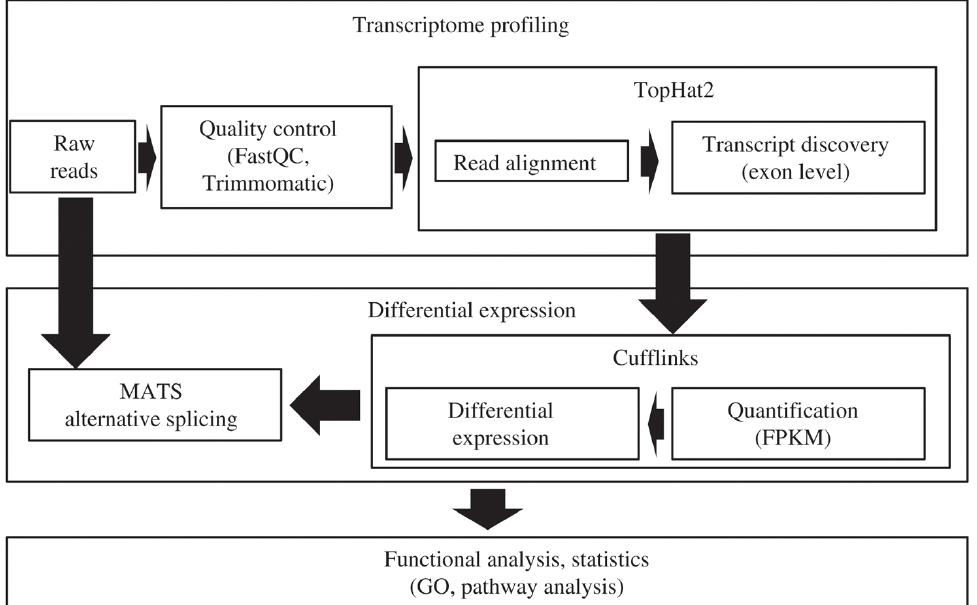
Figure 1: Scheme of transcriptome profiling analysis: from read alignment and mapping to differential gene expression and alternative splicing